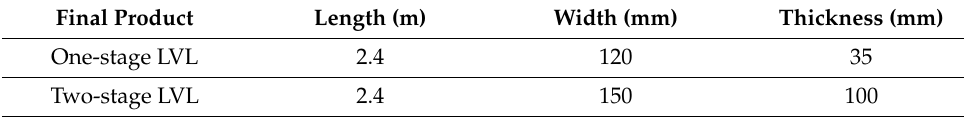
Table 5. Final product